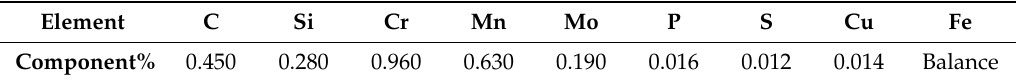
Table 1. Composition of 42CrMo